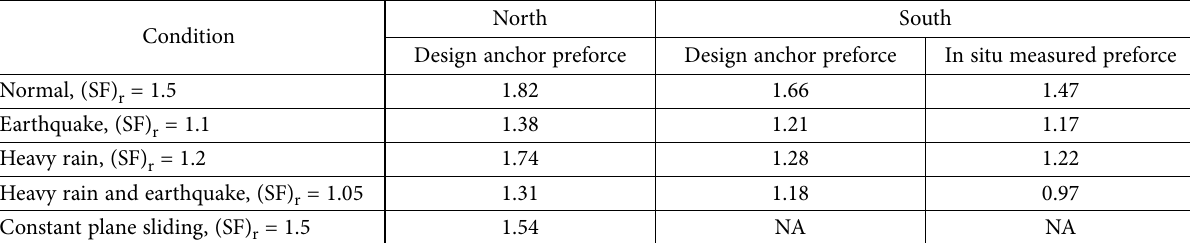
Table 4. Safety factor results of slope stability